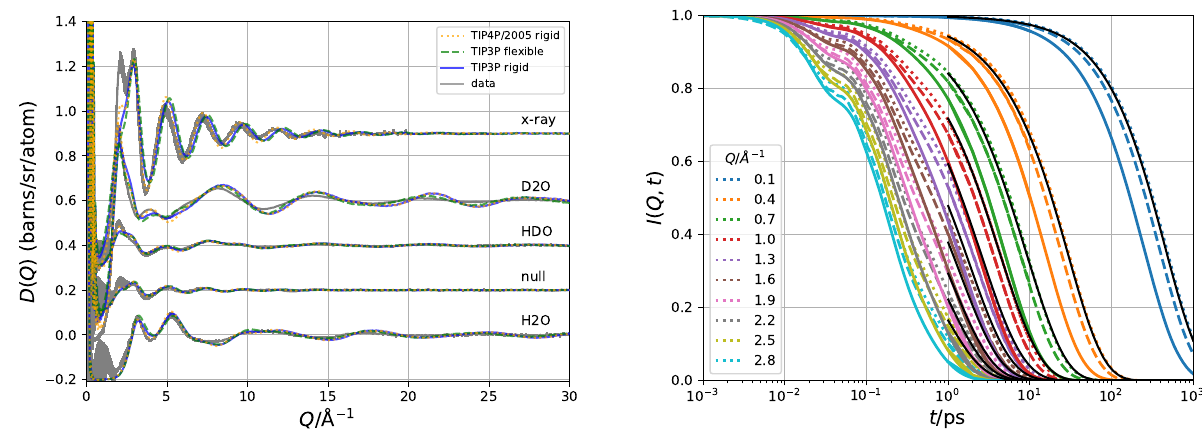
Figure 5. Left: di ff ractograms for X-rays and neutrons with four di ff erent isotopic substitutions for each of the three water models as well as di ff raction data from [36] with di ff erent o ff sets for better visibility respectively. Right: intermediate scattering functions, black solid lines refer to intermediate scattering functions from [37], solid colored lines refer to TIP3P rigid, dashed lines to TIP3P flexible, and dotted lines to TIP4P / 2005 water